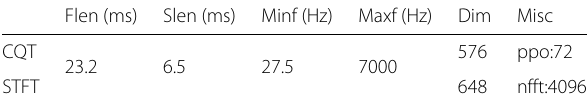
Table 2 Feature specifics used in